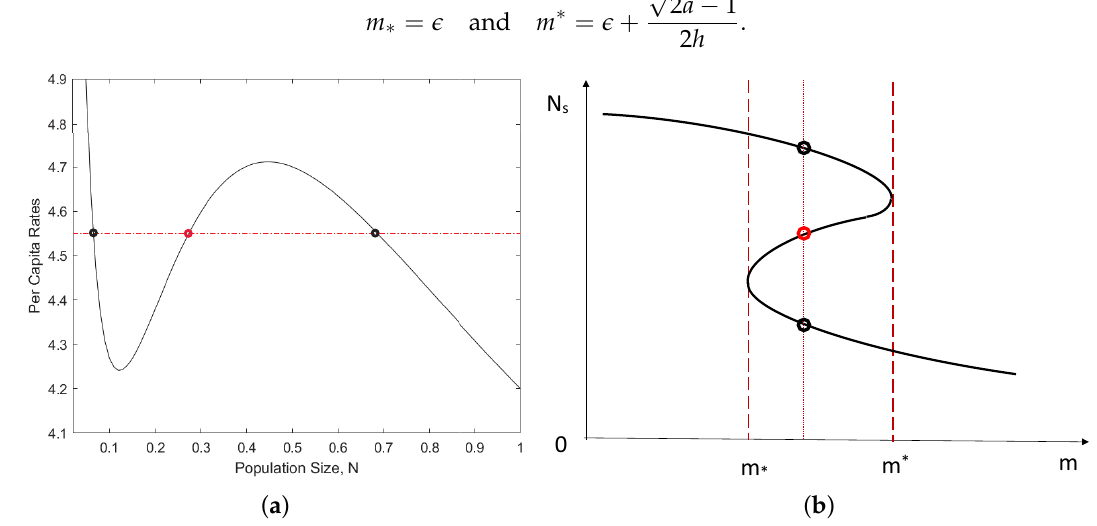
Figure 1. Properties of the model given by Equations (1) and (2) in the baseline case of constant m . ( a ) An example of the relative position of the per capita recruitment rate (black curve) as a function of N (in abstract units) and the per capita withdrawal rate (red line). Any intersection between the two lines is a steady state. The two stable steady states are shown by the small black circles, and the unstable steady state is shown by the red circle. ( b ) A sketch of the bifurcation diagram: The thick black curve shows the steady state value as a function of m . The two long-dashed vertical lines correspond to the bifurcation values of m ; for any value of m such as m ∗ < m < m ∗ (see the vertical dotted line), the system has three steady states, two stable and one